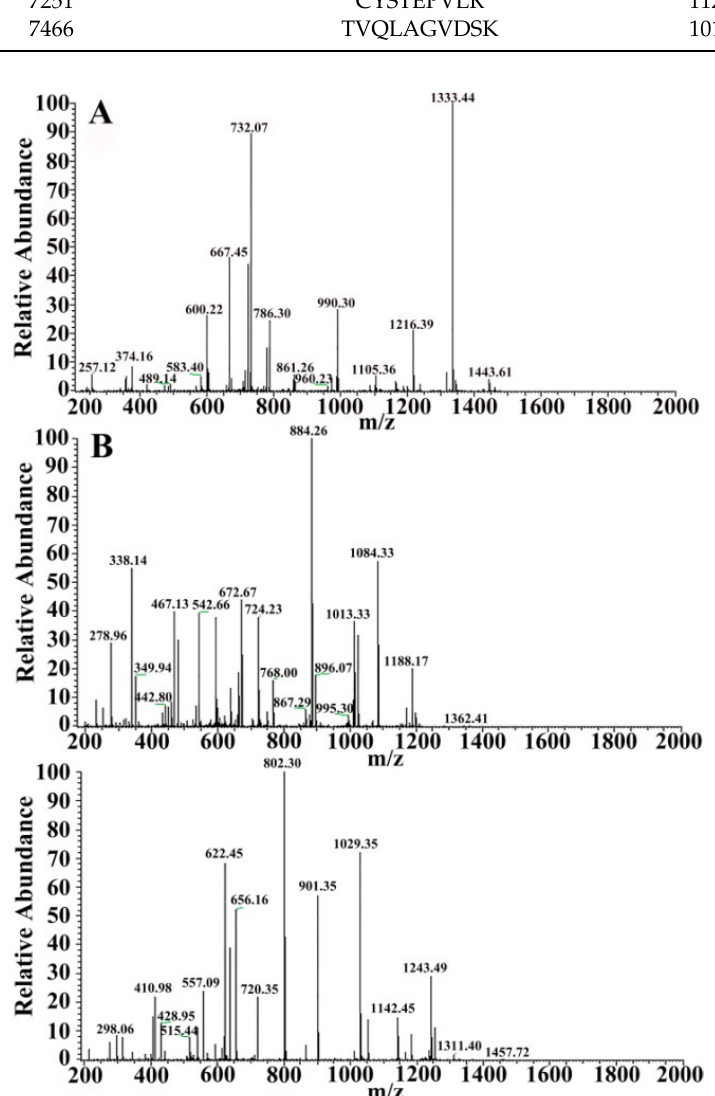
Figure 6. Two-level mass spectrometry of VIT2. ( A ) KKPMDEEENDQVK; ( B ) YDAECEQEYR; ( C ) TITIQVPLWMAGK.